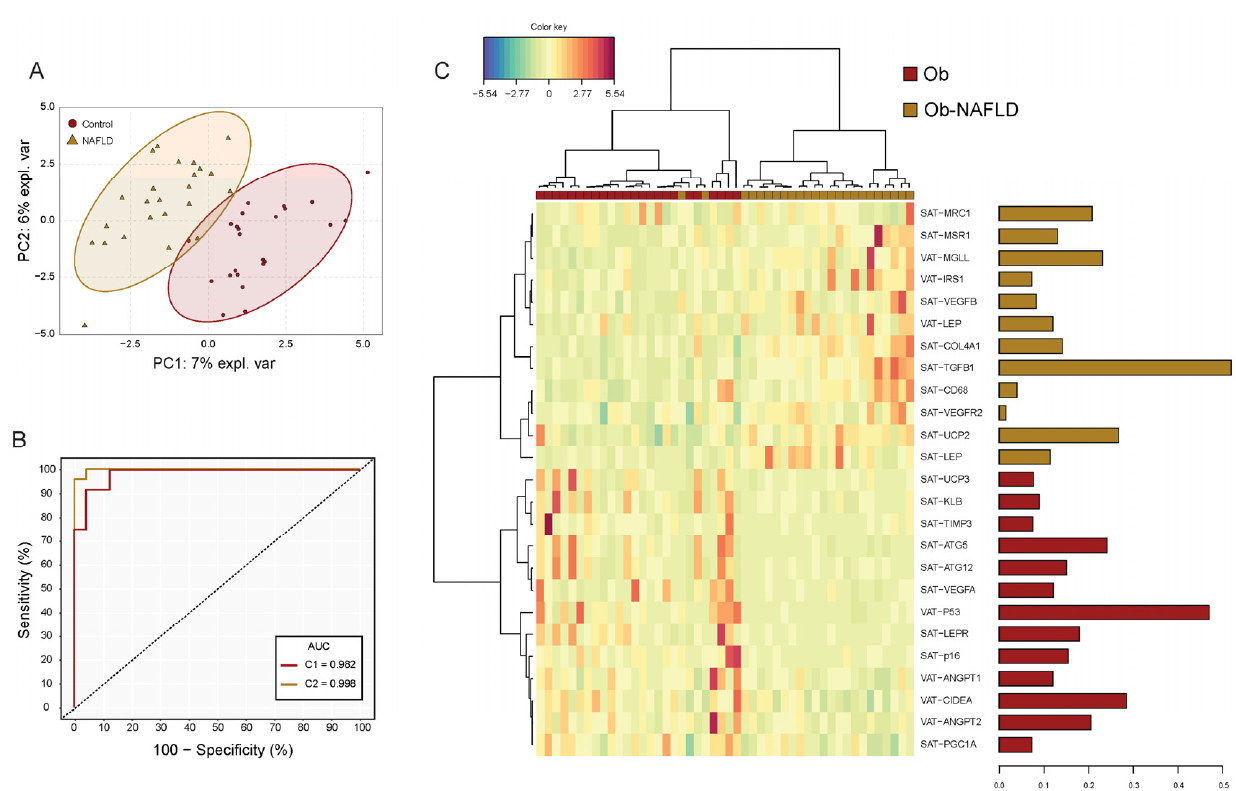
Figure 2. Subcutaneous and visceral fat gene expression signature model for NAFLD. ( A ) Sparse partial least square discriminant analysis (sPLSDA) individual scatter score plot (X-axis: component 1 = 25 genes; Y-axis: component 2 = 25 genes). Ellipses shades indicate 95% CI. ( B ) Receiver operating characteristic (ROC) analysis of the gene expression signature model. Red line corresponds to the accuracy classification performance of component 1-genes whereas yellow line to the model composed by genes ( n = 50) of both components. ( C ) Hierarchical dendrogram-heatmap of the genes conforming sPLSDA Component 1. Log2 transformation is performed on the mRNA raw values of each gene. Complete linkage clustering method with Euclidean distance are used. The contribution of each gene for the model is represented in the barplot where each bar length corresponds to the loading weight (importance) of each variable. Bar color indicates the group in which the mean gene expression is greater.